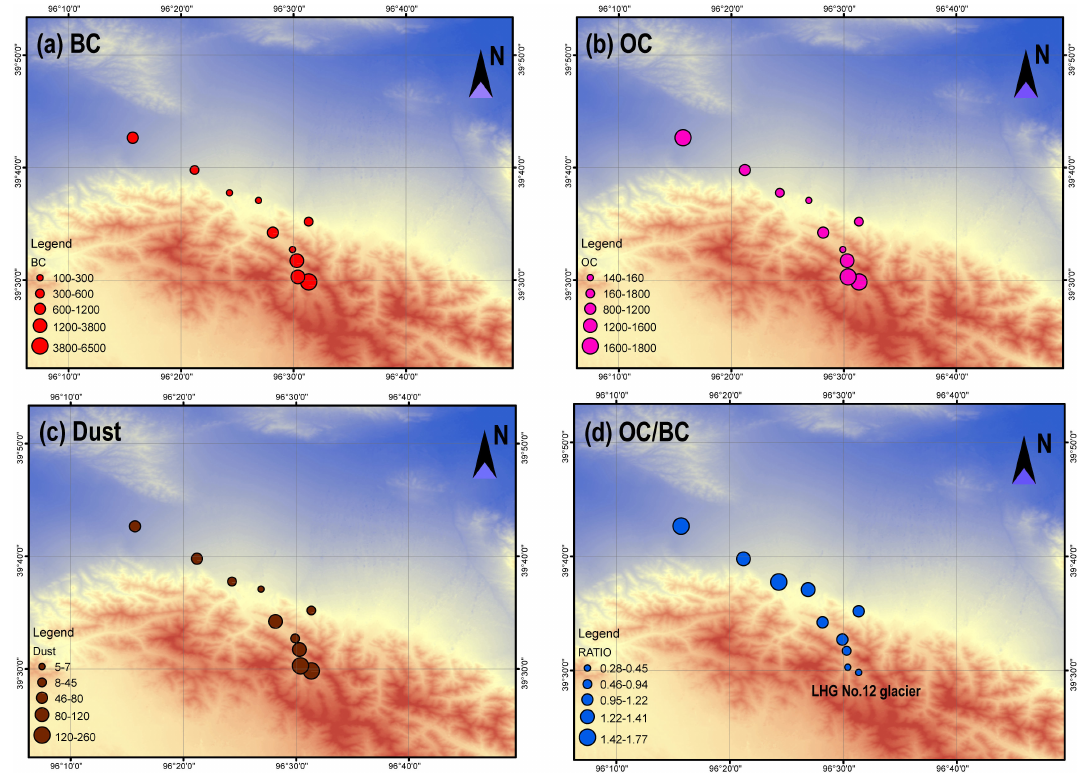
Figure 3. Spatial distributions of light-absorbing impurities in snow at the Laohugou region. (a) BC (ngg − 1 ), (b) OC (ngg − 1 ), (c) dust (µgg − 1 ), and (d) ratio of OC to BC (OC / BC). Table 3. Comparison between measured albedo by ASD and simulated albedo (SA) by the SNICAR model. Selected site